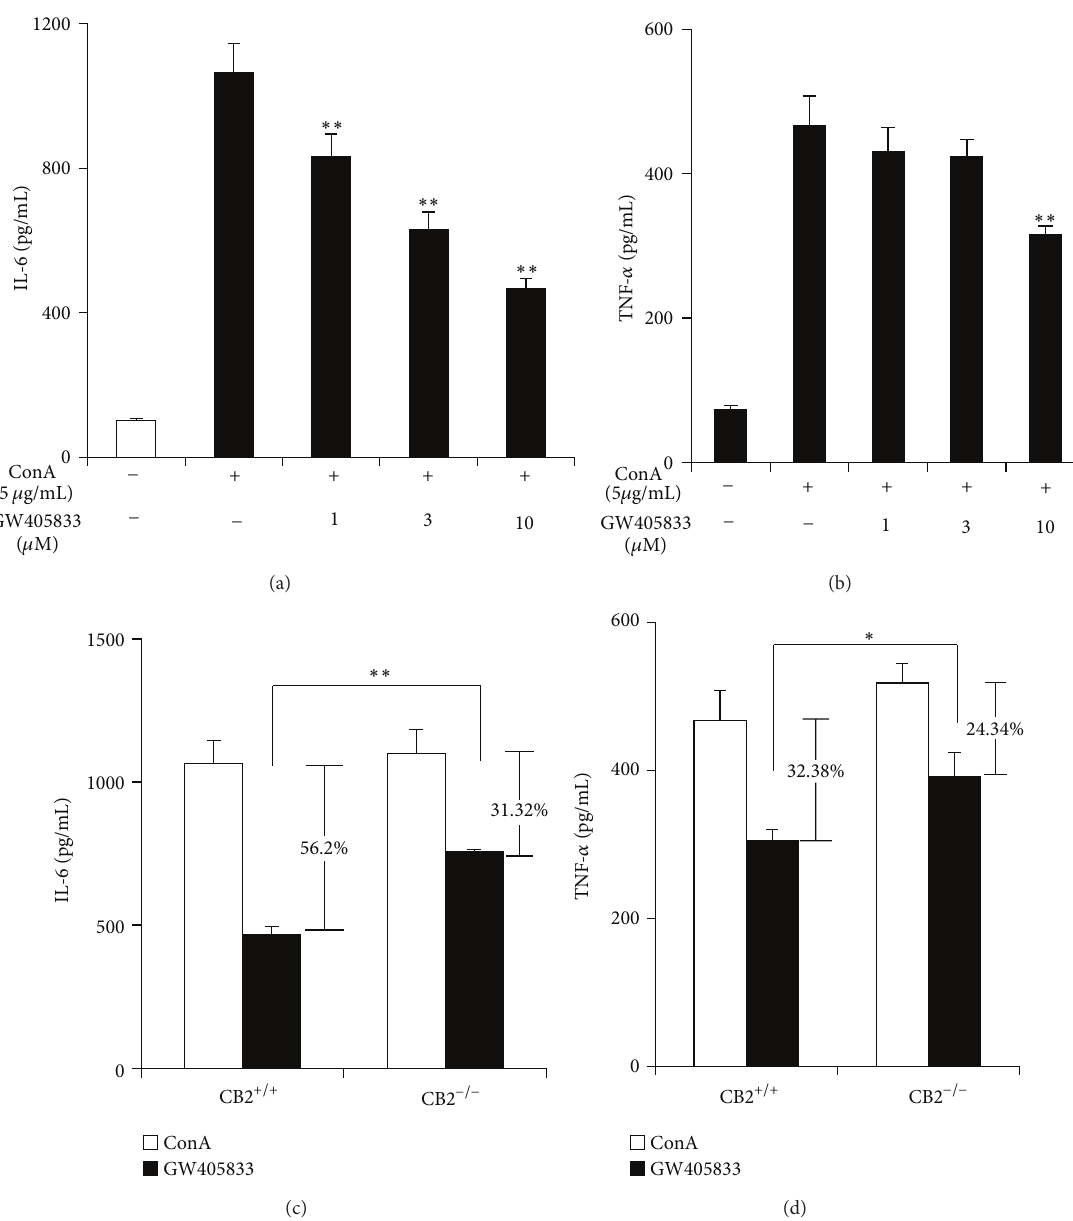
Figure 3: CB2R partially mediates the inhibitory effects of GW405833 on ConA-induced TNF- 𝛼 and IL-6 production in splenocytes. (a)-(b) Splenocytes isolated from CB2R +/+ mice were treated with vehicle or ConA (5 𝜇 g/mL) in the absence or presence of GW405833 (1–10 𝜇 M) for 24 h. The levels of IL-6 and TNF- 𝛼 in the supernatants were detected by ELISA. Data are means ± SD ( 𝑛 = 3 ), ∗ 𝑃 < 0.05 , and ∗∗ 𝑃 < 0.01 versus ConA. (c)-(d) Splenocytes isolated from CB2R +/+ and CB2R −/− mice were treated with ConA (5 𝜇 g/mL) in the absence or presence of GW405833 (10 𝜇 M) for 24 h. The levels of IL-6 and TNF- 𝛼 in the supernatants were detected by ELISA. Data are means ± SD ( 𝑛 = 3 ), ∗ 𝑃 < 0.05 , and ∗∗ 𝑃 < 0.01